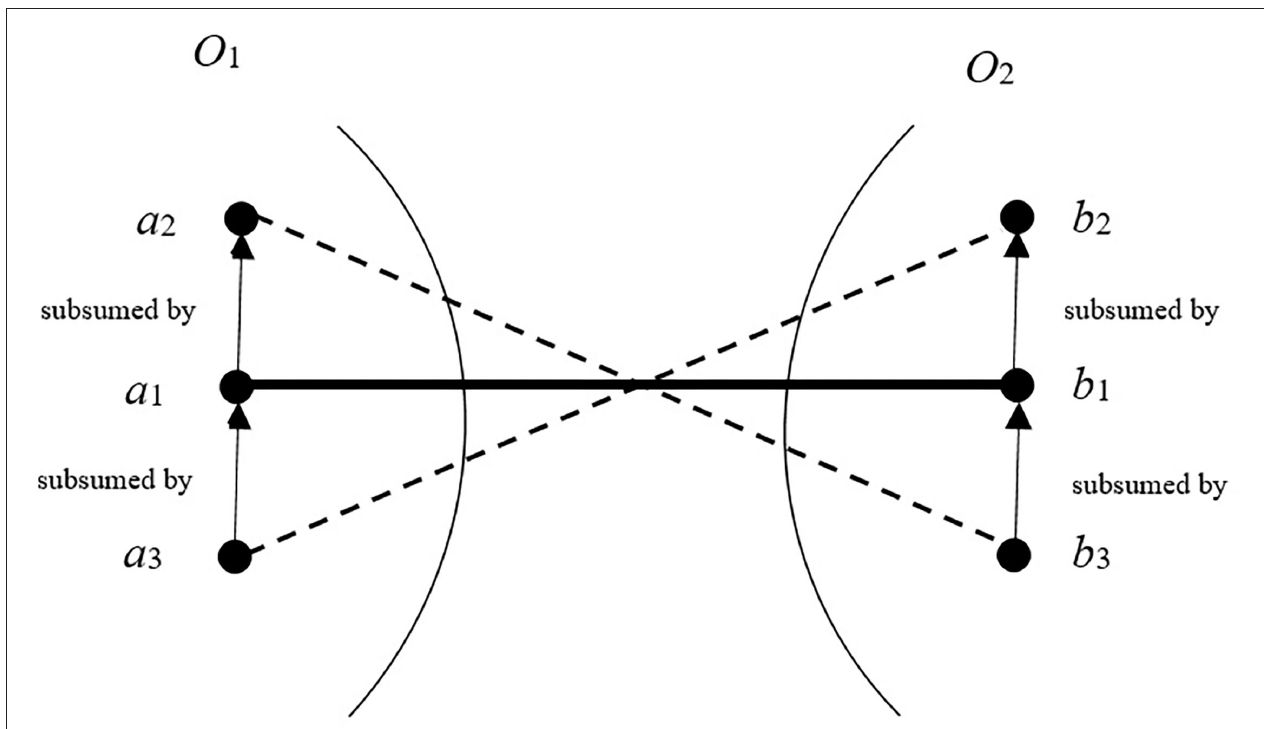
FIGURE 2 | Logical contradiction between